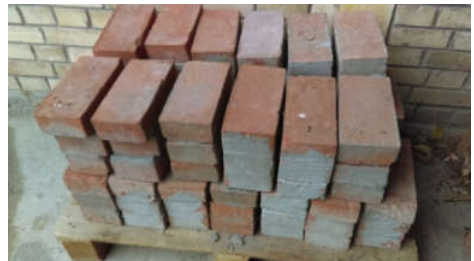
Figure 1. Wall specimens for the initial shear strength.